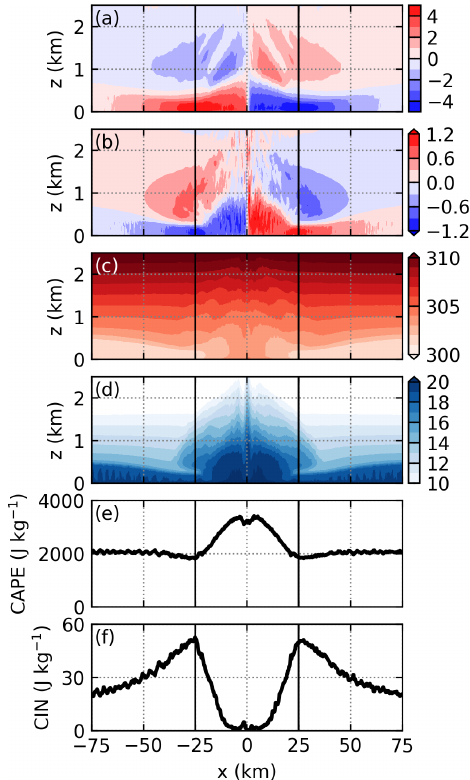
Figure 7. The same as Fig. 5 except at t = 7h